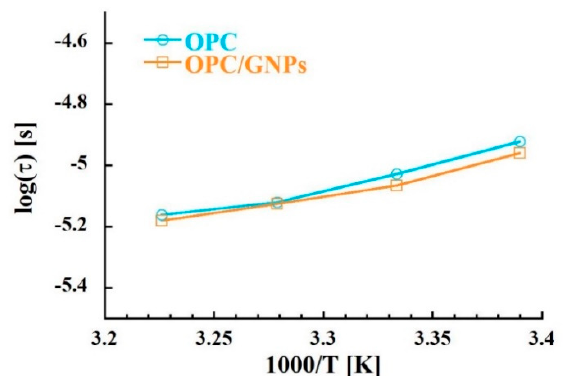
Figure 8. Temperature dependence of relaxation times extracted by the position of the peak maximum in the loss tangent.